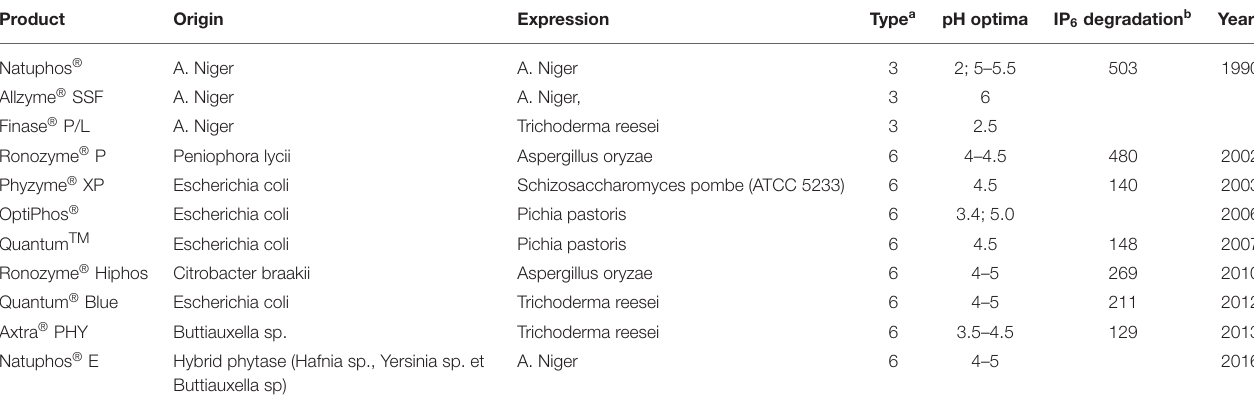
TABLE 2 | Characteristics of some commercial microbial